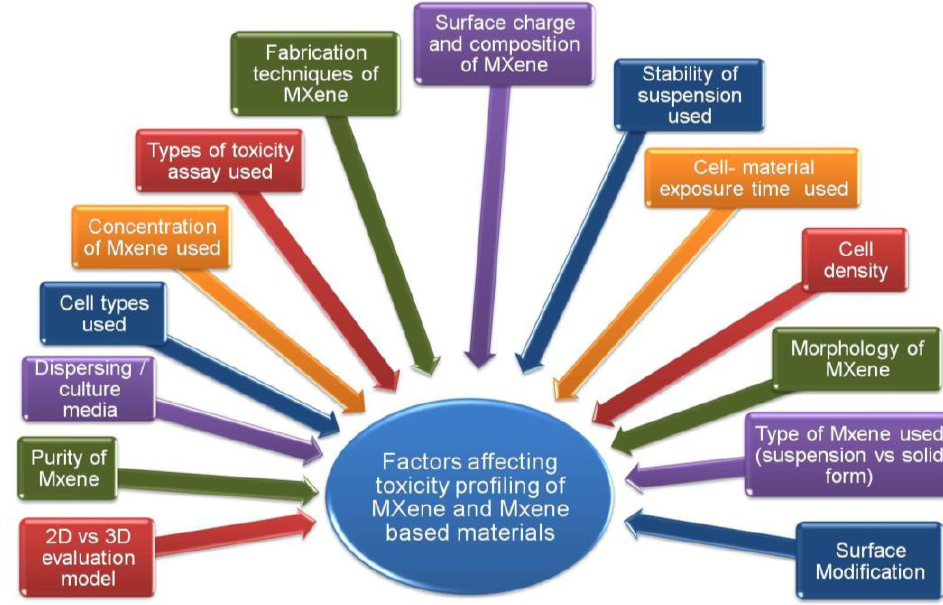
Figure 12. Factors affecting toxicity profiling of MXenes.